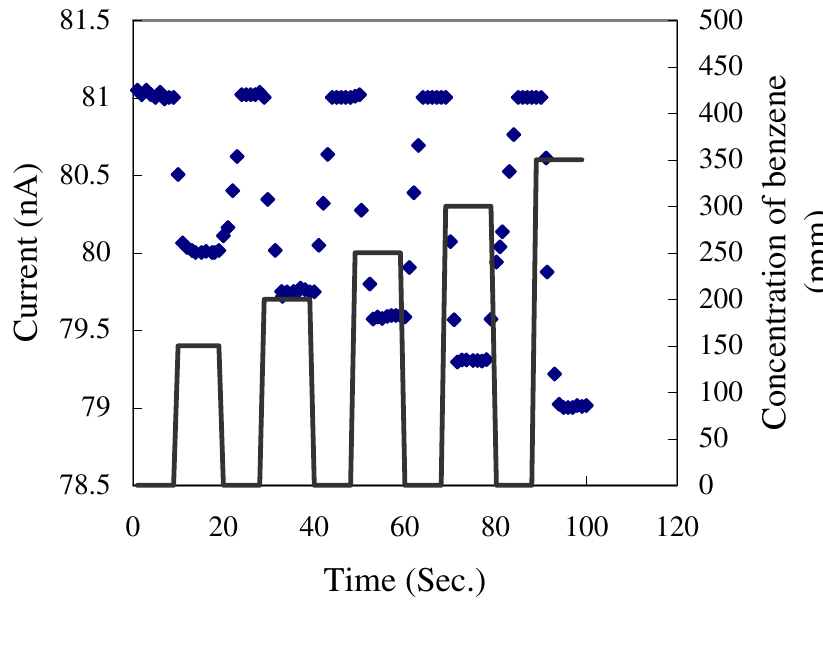
sensor when exposed to step 2